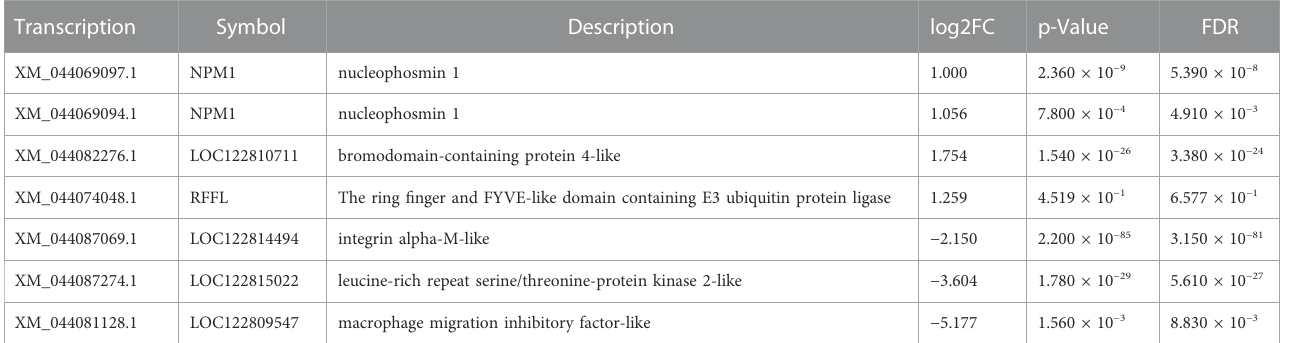
TABLE 2 Select differentially expressed genes in the